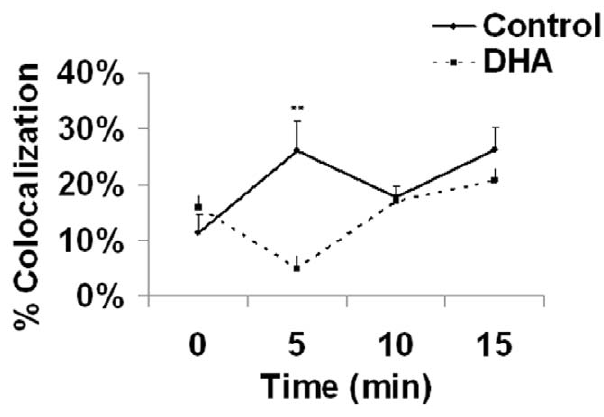
Figure 7. Colocalization of raft marker GM1 with IFN c R is impaired in DHA-treated, non-infected J774A.1 cells primed with IFN c . Macrophages were incubated with 50uM DHA for 24 hours and then stimulated with IFN c (100 U/ml) for0–15 min on chambered slides. The cells were then fixed, washed and immunostained with FITC- CTx (GM1) and IFNgR1 antibodies as described in the Materials and Methods . Images were then collected by confocal analysis at 6 126 magnification. Colocalization of IFN c R1 with the raft marker was quantified as percentage of colocalized area (both green and red) over total raft area (green). Images were randomly captured from a minimum of 10 images per slide, with a minimum of 4 cells per image. Data are representative of three independent experiments. Significant differenc- es were found between control and DHA groups at 5 min. Abbrevia- tions used: DHA, docosahexaenoic acid.